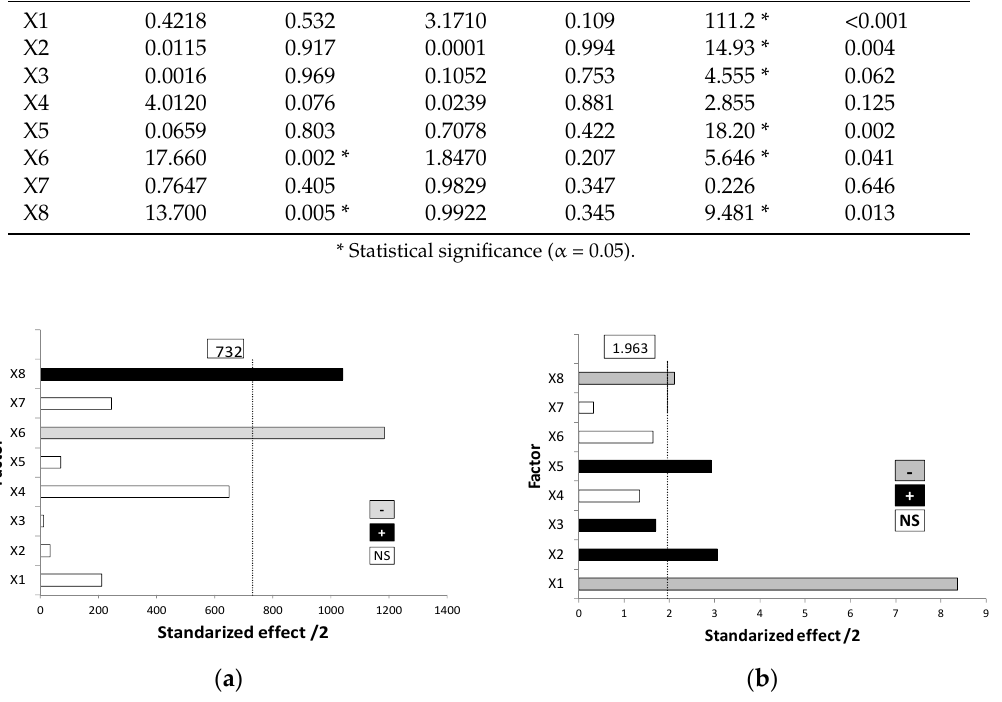
Table 5. Regression equations and fitting parameters for the dependent variables evaluated. MSE: mean square